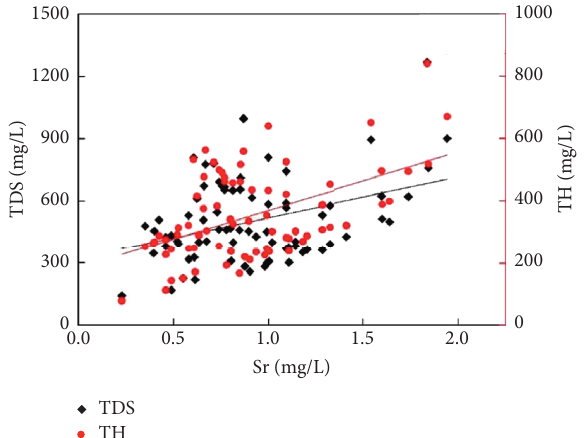
Figure 6: Relationship between groundwater strontium, TDS, and TH. Figure 7: Relationship between groundwater strontium and bicarbonate.